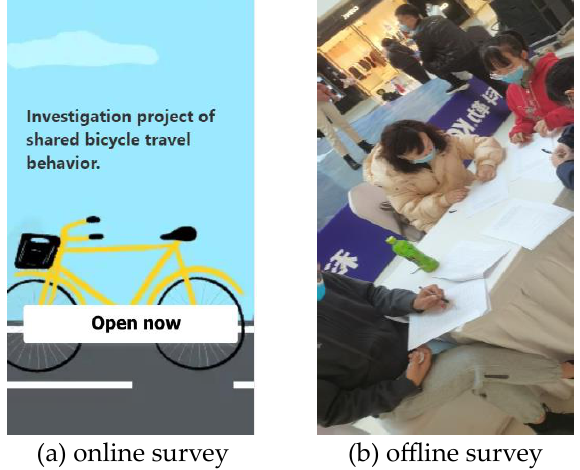
Figure 2. Investigation process.